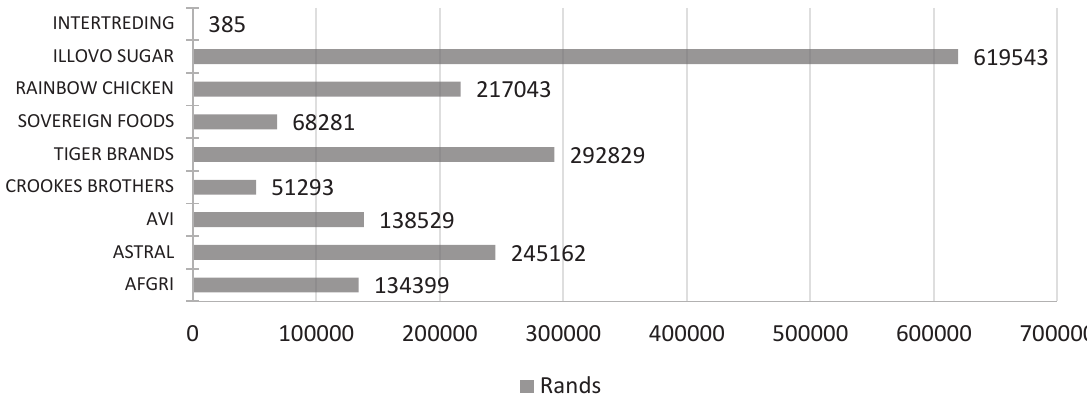
Figure 3. Deferred tax liabilities (Rand values in 000’s)